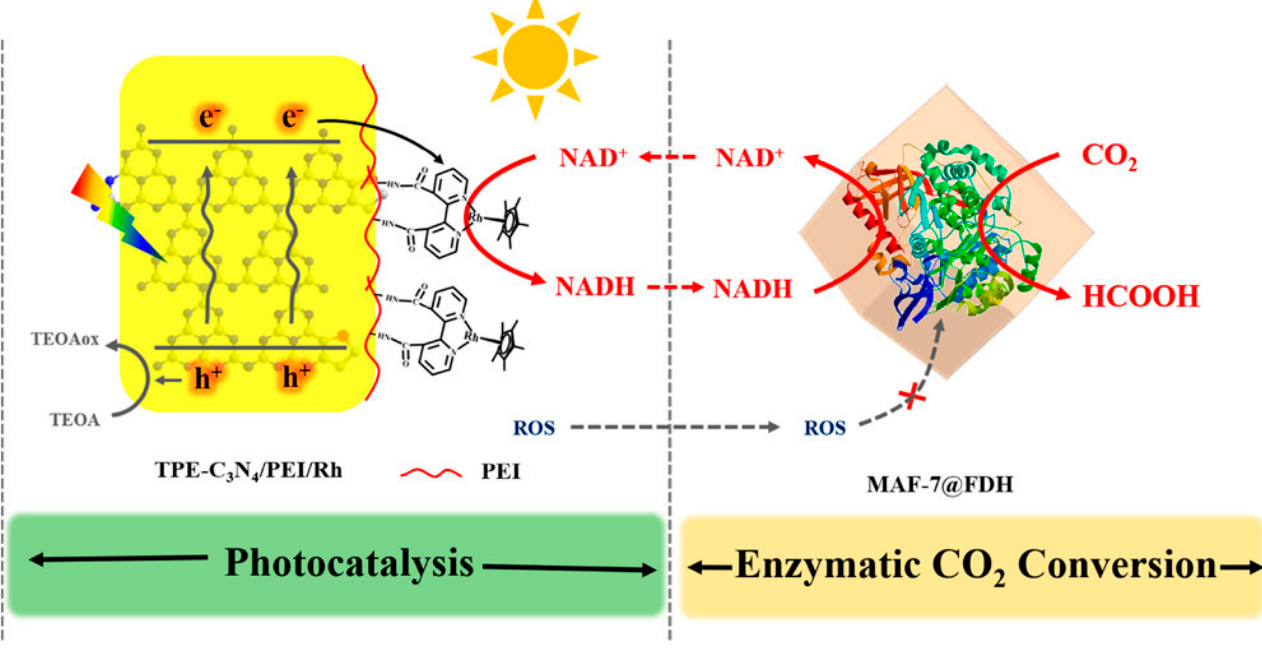
Figure 4. Modified graphitic carbon nitride decorated with a Cobalt complex for photocatalytic NADH regeneration (Reprinted with permission from Ref. [148]. Copyright 2020, American Chemical Society).